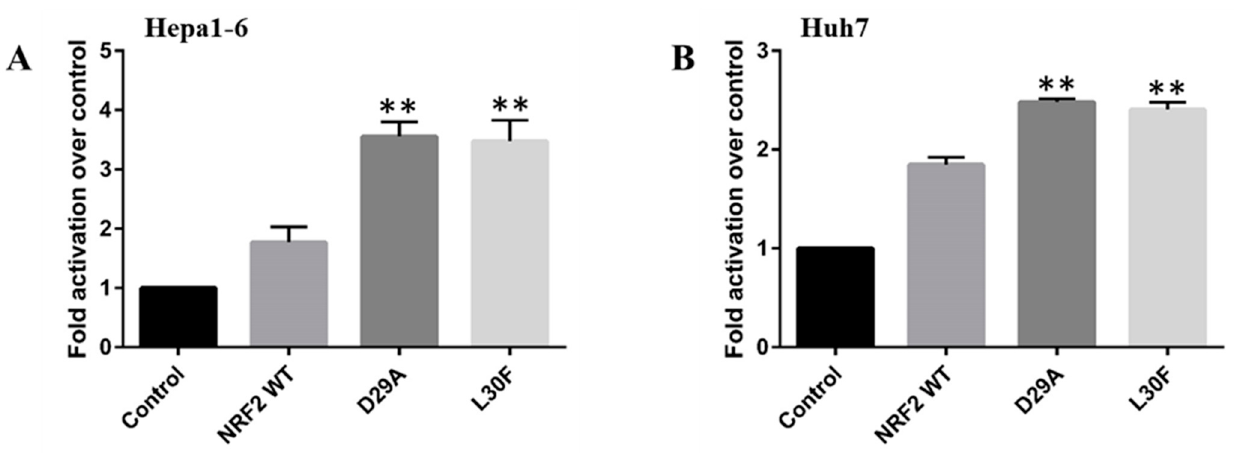
Figure 4. The ability of the NRF2 WT and MTs to transactivate MMP9 promoters in Hepa1-6 ( A ) and Huh7 ( B ) cells. Cells were cotransfected with a MMP9 luciferase reporter (250 ng) along with either an empty expression vector (serving as a control) or expression vectors (50 ng) for the indicated NRF2 in 24-well culture plates. Data represent the mean ± SEM of 6 ( A ) and 3 ( B ) independent experiments (**, p <